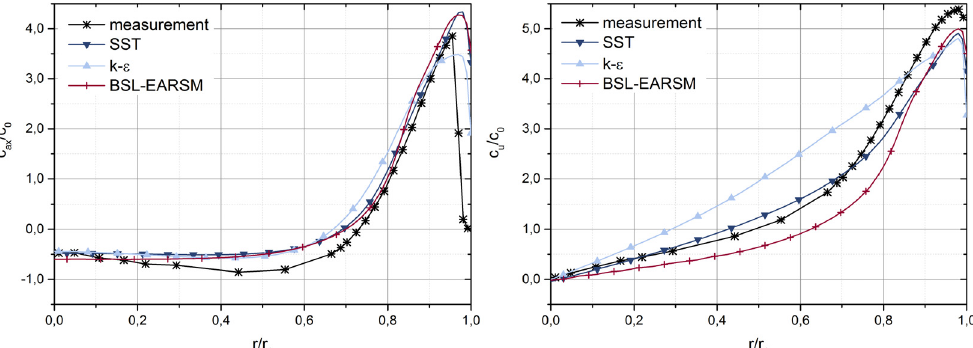
Fig. 5. Comparison of axial ( c ax ) and tangential ( c u ) velocity pro fi les at the upper measurement section (L1) with the experimental velocity pro fi les at the part load, Mossinger [15]; c 0 is the average velocity at the measurement plane.